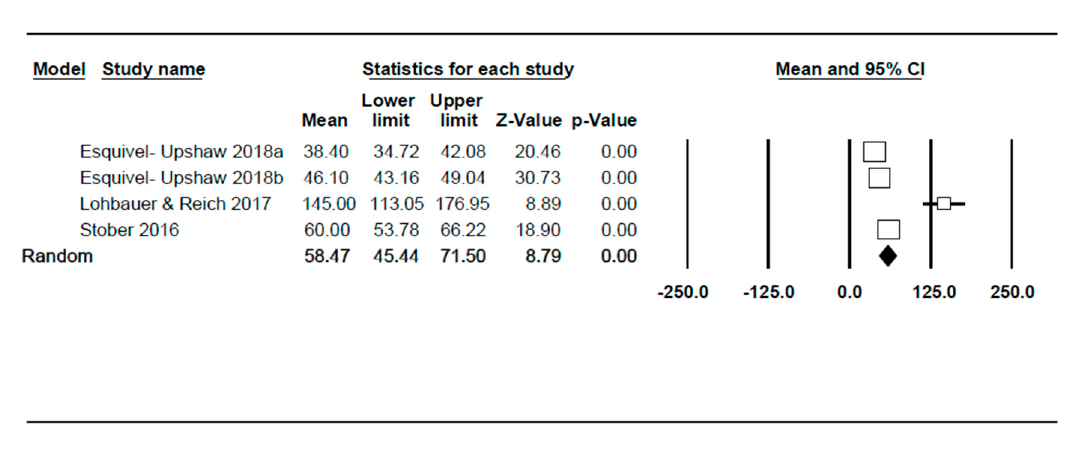
Figure 5. Forest-plot. Mean of the maximum wear reported by each author over time and the calculation of the global effect mean for monolithic zirconia restorations.